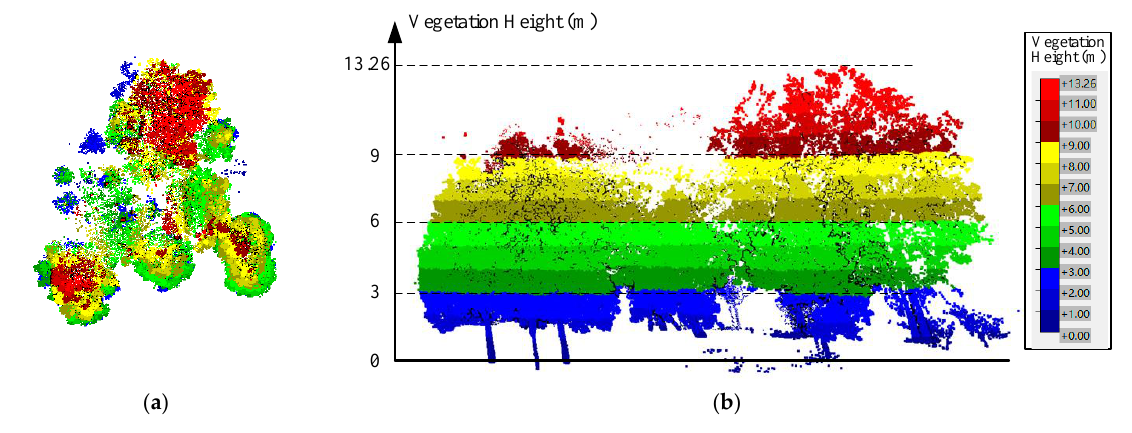
Figure 5. Schematic diagram of a complex vegetation coverage scene (LiDAR datasets). ( a ) Vertical view. ( b ) Survey view. Table 5. Quality comparison of three point cloud datasets collected from the same complex vegeta- tion coverage scene.